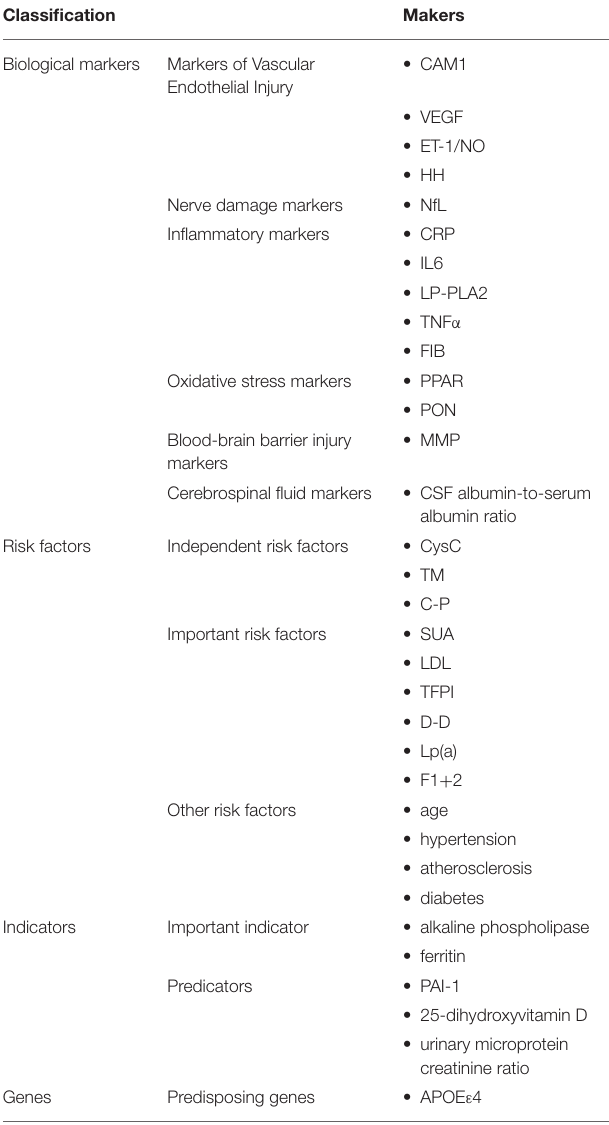
TABLE 2 | Classification of CSVD-related influencing